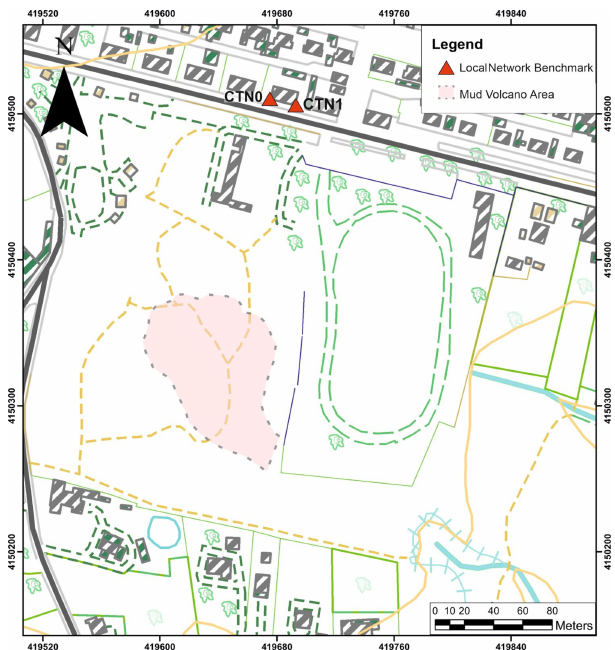
Figure 3. Chorography of the eastern periphery of the inhabited area of Caltanissetta (Santa Barbara Village). The base map is Carta Tecnica Regionale 2008 (CTR). The reference system is WGS 84/UTM zone